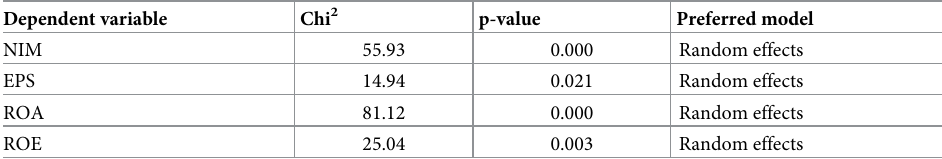
Table 8. Hausman test results.